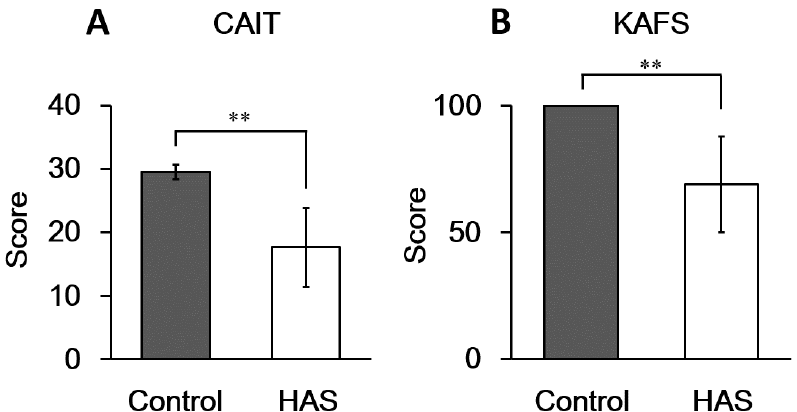
Figure 5. Self-evaluated scores of subjective ankle instability. Average scores reported via ( A ) CAIT and ( B ) KAFS. The HAS group was classified according to self-evaluation without clinical diagnosis. There were 8 subjects in the control group (16 ankles) and 5 subjects in the HAS group (8 ankles). CAIT, Cumberland Ankle Instability Tool; KAFS, Karlsson ankle function score; HAS, history of ankle sprain. ** A statistically significant difference was observed at p < 0.01.